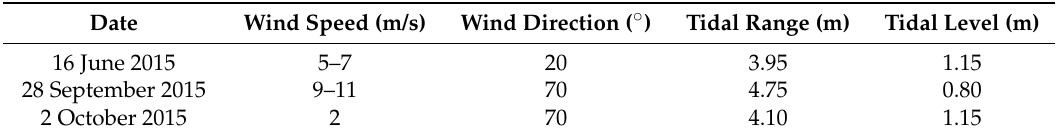
Table 1. Meteorological conditions, tidal ranges and tidal levels with respect to marine charts datum for the three